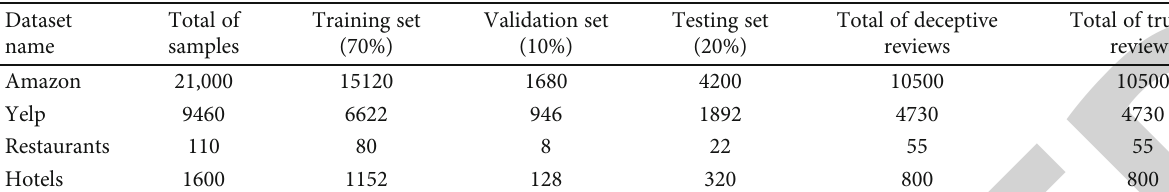
Table 1: Splitting of datasets used in the experiments.